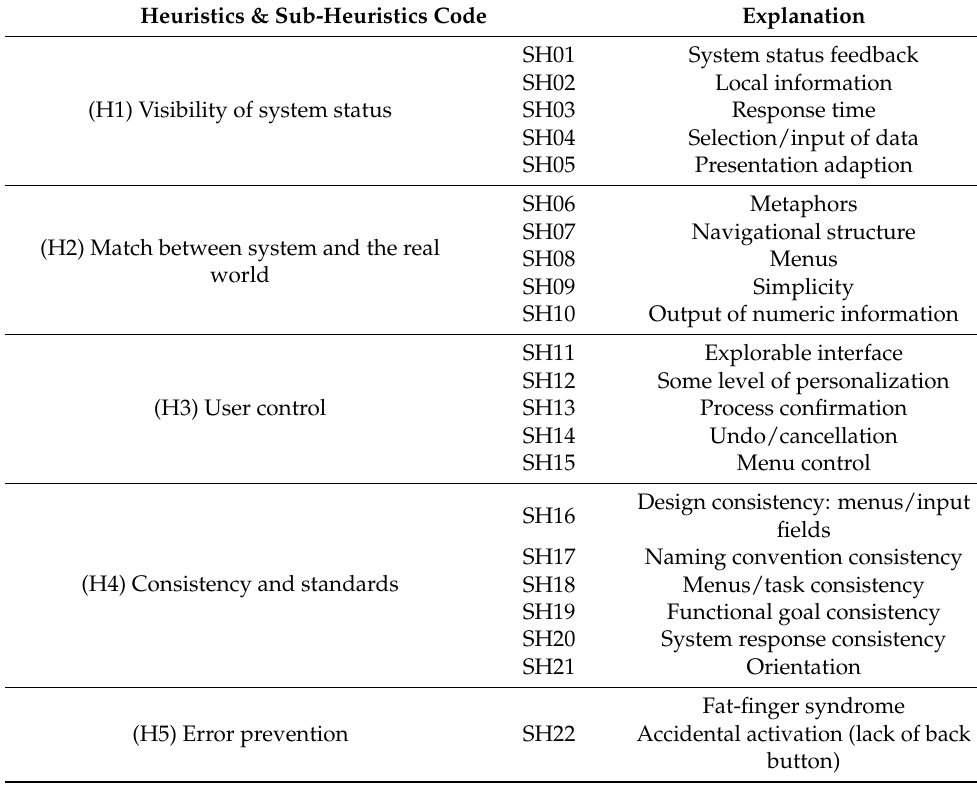
Table 1. Checklist for Heuristic